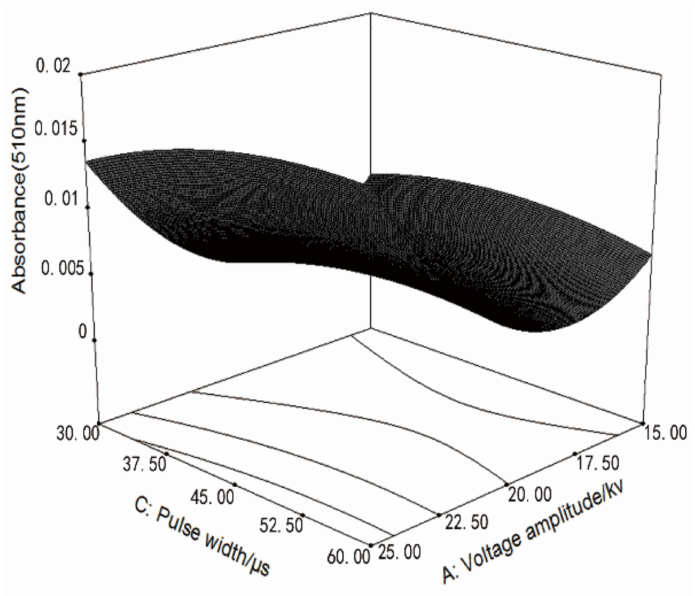
Figure 6. Response surface analysis of voltage amplitude and pulse duration.